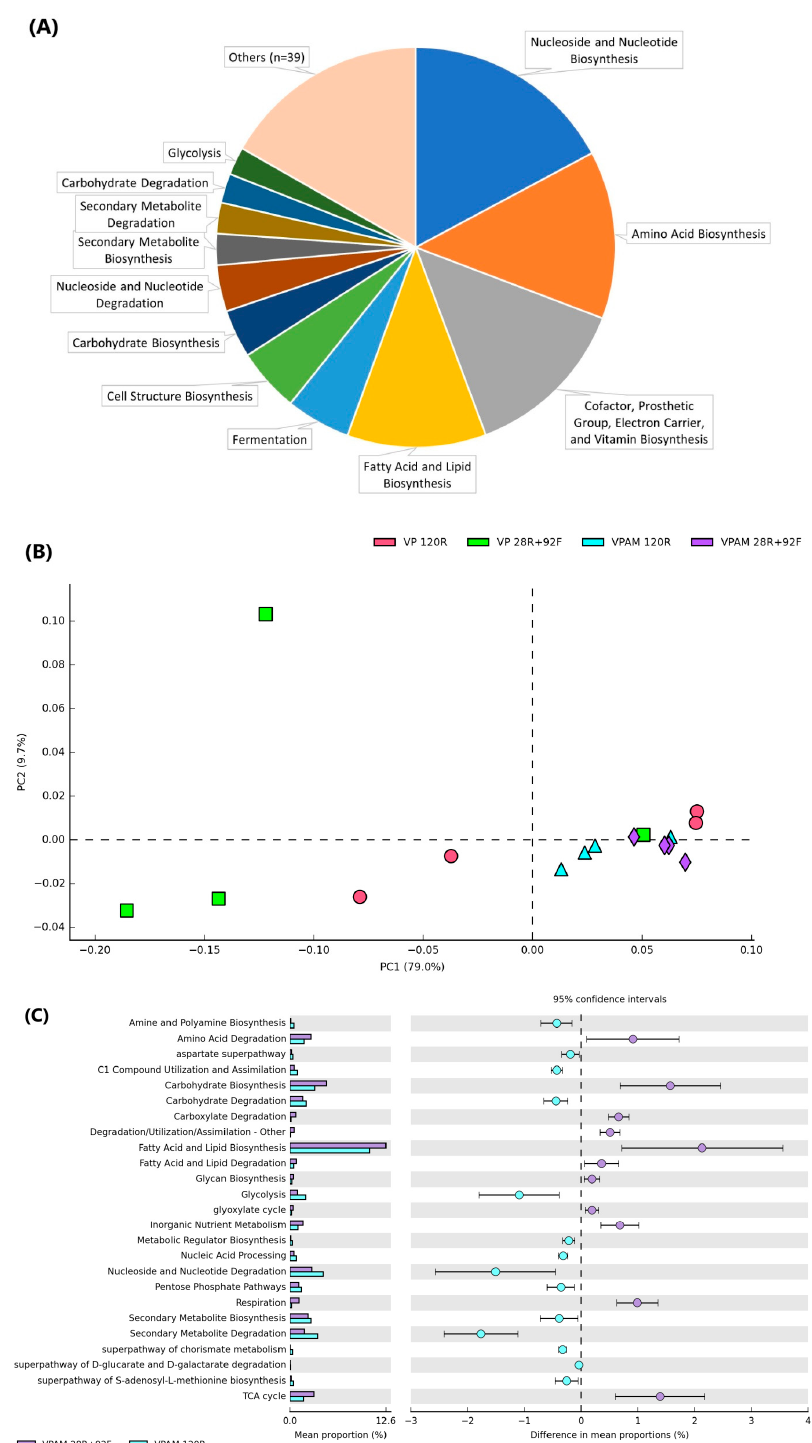
Figure 6. Predicted metabolic functions (level 2 KEGG pathways using PICRUSt2) based on the microbiome of meat samples. ( A ) Relative abundance across all samples (pathways with < 2% relative abundances are included in “Others”), ( B ) Principal coordinate analysis of the predicted function of meat bacterial communities separated by treatment, ( C ) Mean abundance and difference of significantly affected pathways between VPAM 28R+92F and VPAM 120R samples. Treatments: vacuum packaging for 120 days (refrigerated) (VP 120R), vacuum packaging for 28 days (refrigerated) + 92 days (frozen) (VP 28R+92F), vacuum packaging with antimicrobial for 120 days (refrigerated) (VPAM 120R), vacuum packaging with antimicrobial for 28 days (refrigerated) + 92 days (frozen) (VPAM 28R+92F). Pairwise comparisons between treatments showed that VPAM 28R+92F samples formed a distinct cluster and were separated from VPAM 120R samples ( p < 0.05) driven by 20/51 (39%) level 2 KEGG pathways that were different ( p < 0.05). Considering the most abundant functions that were significantly affected, pathways related to carbohydrate and lipid biosynthesis were enriched in VPAM 28R+92F samples, while pathways associated with degradation of nucleosides/nucleotides (purine and pyrimidine) and secondary metabolites ( D -fructuronale, D -galactarate, D -galacturonate, and D -glucarate) were more abundant in VPAM 120R samples (Figure 6C). Additionally, four pathways associated with the generation of precursor metabolite and energy (respiration, TCA cycle, glycolysis, and pentose phosphate pathway) were different between VPAM 28R+92F and VPAM 120R samples. Respiration and TCA cycle were more abundant ( p < 0.05) in VPAM 28R+92F samples. Glycolysis and pentose phosphate pathway, on the other hand, were enriched ( p < 0.05) in VPAM 120R samples. Additionally, degradation of amino acids and lipids (beta oxidation and androstenedione degradation) tended ( p = 0.06) to be greater in VPAM 28R+92F samples than in VPAM 120R, while the aspartate superpathway tended ( p = 0.06) to be enriched in the latter. A closer examination of level 3 KEGG pathways within amino acid degradation showed that arginine, leucine, and tyrosine degradation pathways were enriched in VPAM 28R+92F samples, whereas degradation of arginine, ornithine, and putrescine were more abundant in VP 120R samples.